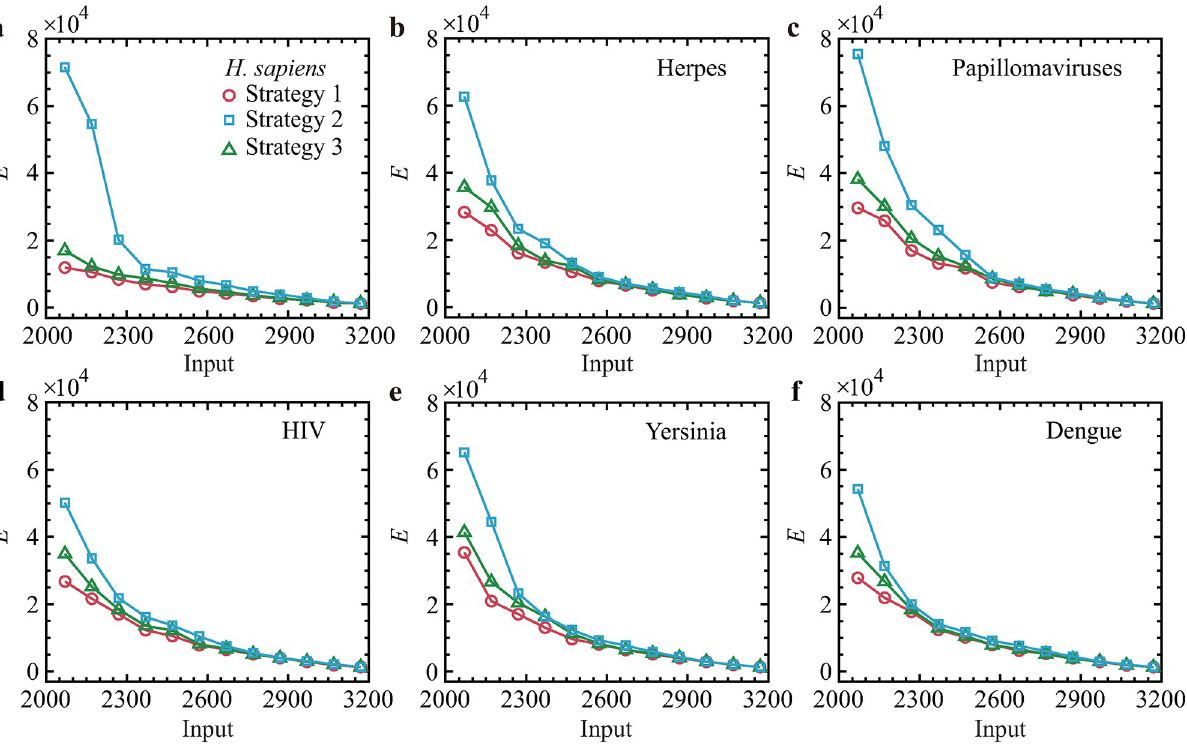
Fig 6. Control energy as functions of the number of driver nodes provided by three strategies. (a) H. sapiens . We choose all 1, 340 essential genes as driver nodes for H. sapiens and all pathogen-related genes as driver nodes for five different pathogens in (b)-(f) . The numbers of pathogen-related genes are 414 for (b) , 340 for (c) , 291 for (d) , 340 for (e) , and 116 for (f) . Each data point is the mean of 100 independent realizations.